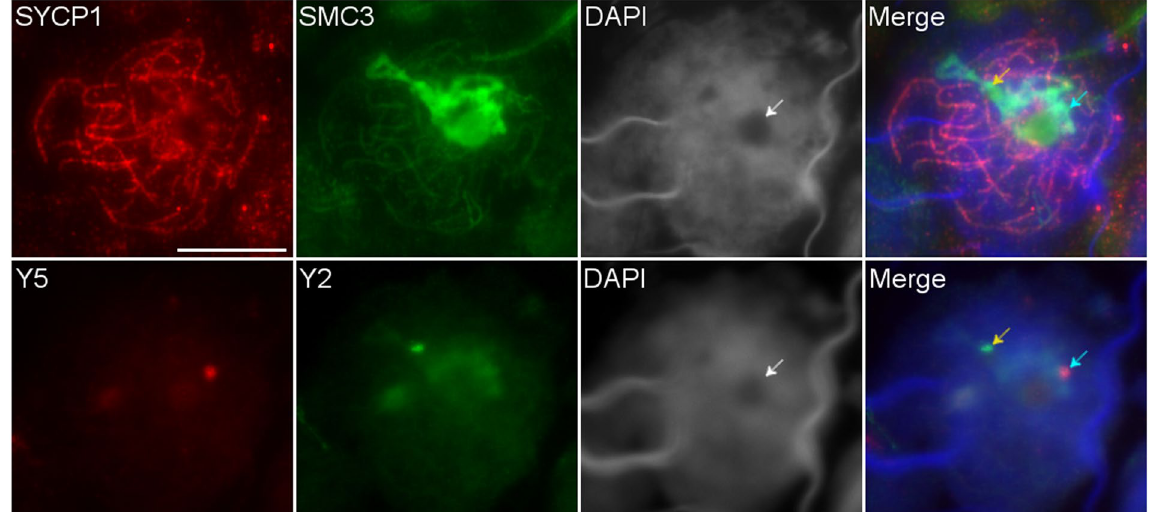
Figure 3. Colocalisation of sex chromosomes with SMC3 accumulation in platypus pachytene cell nuclei. Y specific probes; Y 2 (yellow arrow) and Y 5 (green arrow). The region of SMC3 accumulation is also associated with a large DAPI poor region (white arrow). Scale bar = 10 µ